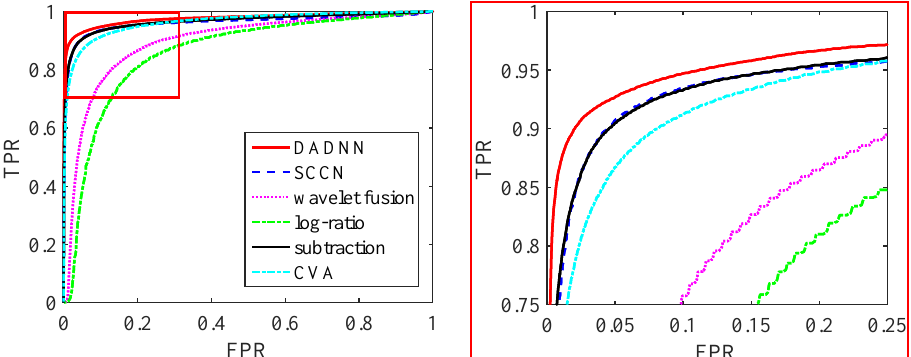
Figure A6. The DIs generated by different methods in the Guangzhou data set: ( a ) CVA, ( b ) subtraction, ( c ) log-ratio, ( d ) wavelet fusion, ( e ) SCCN, and ( f ) DADNN.